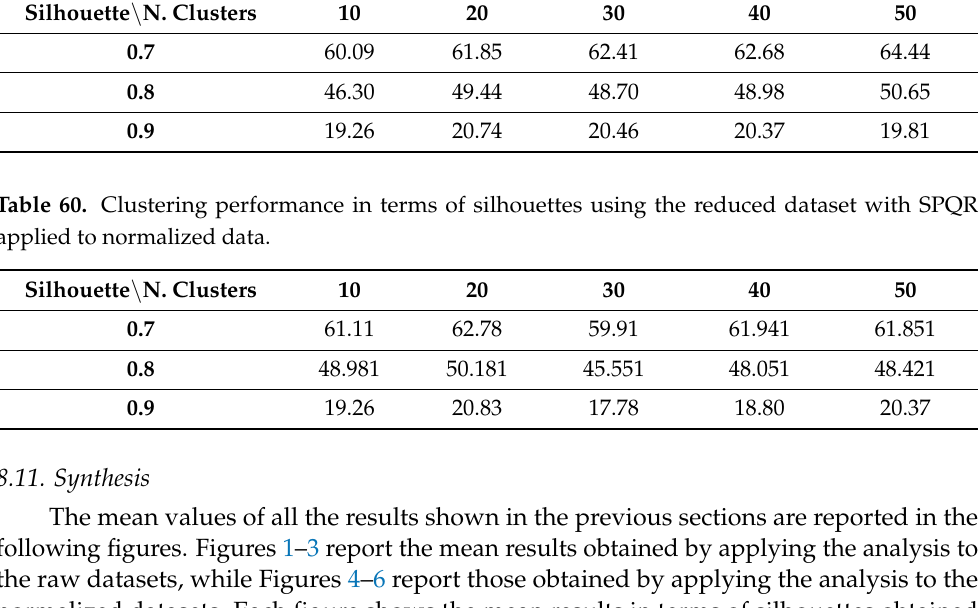
Table 59. Clustering performance in terms of silhouettes using the reduced dataset with PCA applied to normalized data. Silhouette \ N. Clusters